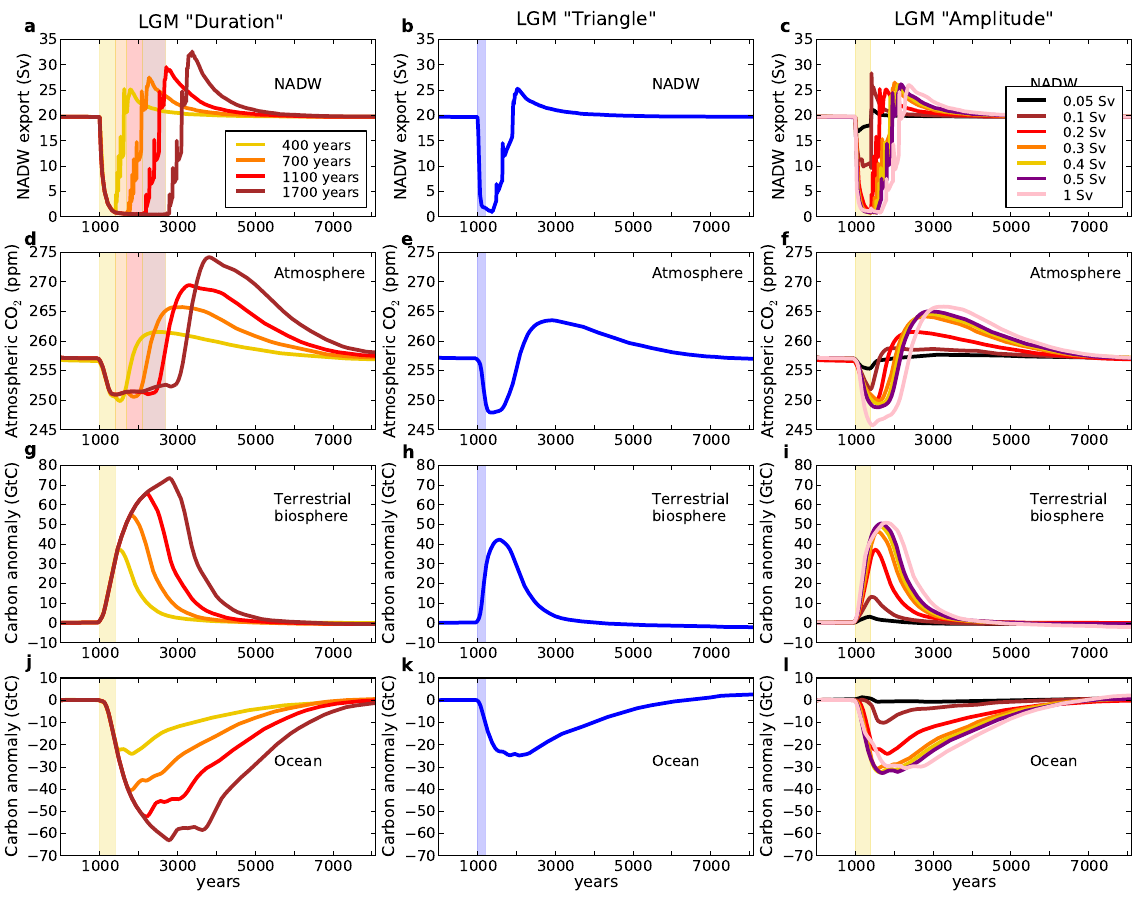
Fig. 10. Evolution of (a, b, c) NADW export (Sv) (maximum of the AMOC), (d, e, f) atmospheric CO 2 (ppm), (g, h, i) carbon content anomaly in the terrestrial biosphere (GtC) and (j, k, l) carbon content anomaly in the ocean (GtC) during the simulations with the Last Glacial Maximum (LGM) background climate state. The fresh water flux is added into the North Atlantic and varies as described in Fig. 1 for the three types of experiments: (a, d, g, i) “Duration”, (b, e, h, k) “Triangle” and (c, f, i, l) “Amplitude”.